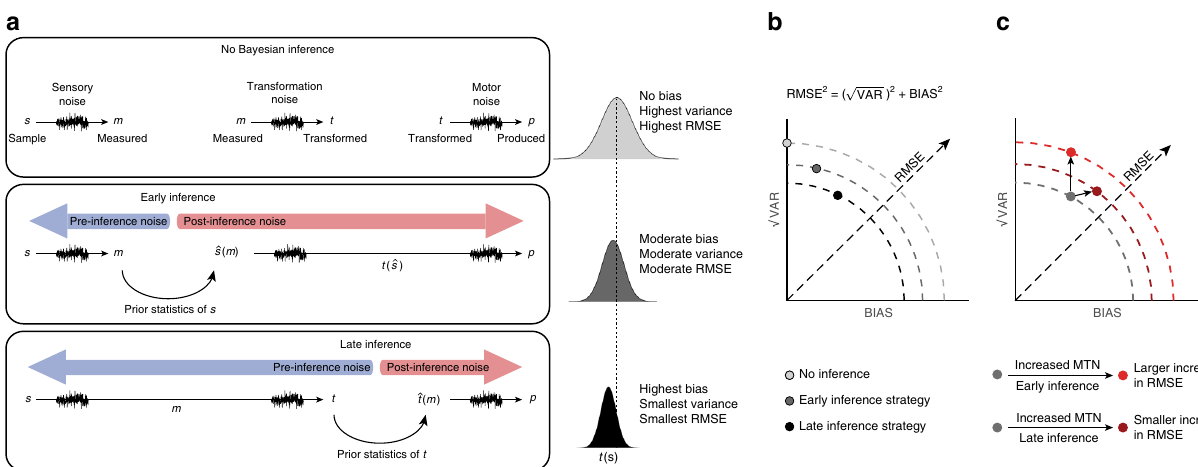
Fig. 1 Inference in the presence of sensory and mental transformation noise (MTN). a Observer models. Top: no inference. The observer makes a noisy measurement ( m ) of a sensory stimulus ( s ), applies a noisy mental transformation to compute t , and aims to produce t through a noisy motor system resulting in p . Across trials, p has a distribution (light gray) centered on the correct value (dashed line). Middle: early inference. After the noisy measurement, the observer uses the prior statistics of s to infer ^ s , uses ^ s to generate t , and uses t to produce p . Since the inference is made before the transformation (early inference), prior-dependent biases only reduce the effect of sensory noise that precedes the inference (pre-inference noise, blue arrow), and not the uncertainty due to the post-inference transformation noise (red arrow), which directly increases variability. In this case, the distribution of p (intermediate gray) is biased but has lower variance. Bottom: Late inference. The inference is made after the transformation based on the prior statistics of t to generate an optimal inference, ^ t , which is then used to produce p . Late inference leads to larger biases but allows the observer to account for both sensory and transformation noise. The distribution of p values is more biased and less variable than the early inference strategy (dark gray bell- shaped distribution). b Variability ( √ VAR), bias (BIAS), and RMSE for the three observer models in panel a . The sum of squares relationship between √ VAR, RMSE, and BIAS (top) can be depicted on a quarter circle (dashed lines) with the radius representing RMSE. Compared to the no inference strategy (light gray), early inference (medium gray) increases BIAS while reducing √ VAR and RMSE. Late inference (dark gray) further increases BIAS